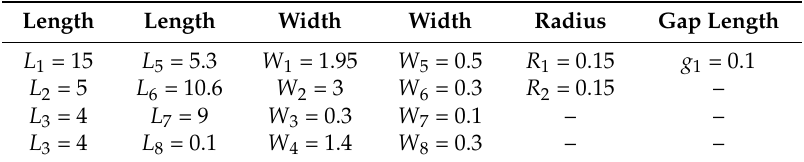
Table 2. Optimized design parameters of the proposed ultra-wideband filter (The units are mm).